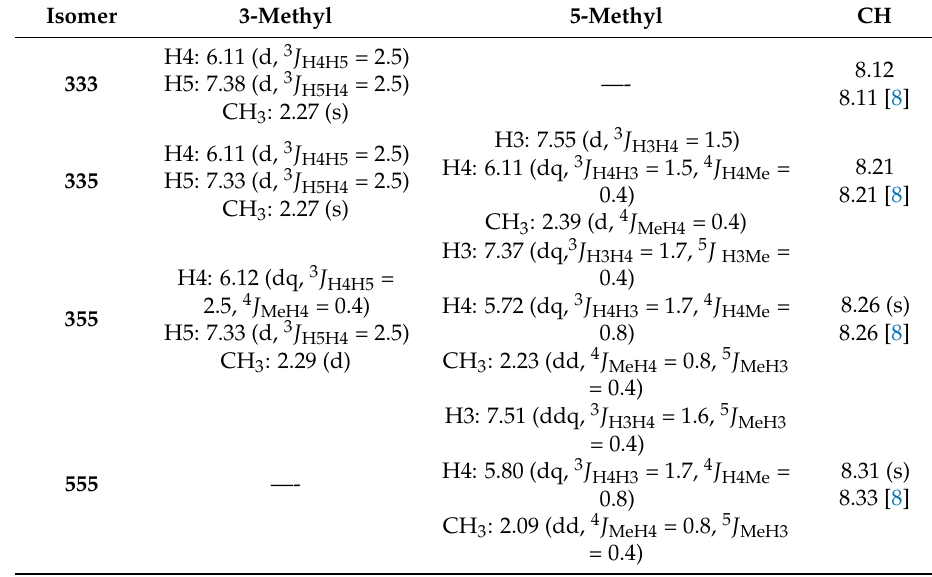
Table 1. 1 H-NMR data of trispyrazolylmethanes at 400.13 MHz. Solvent CDCl 3 . Chemical